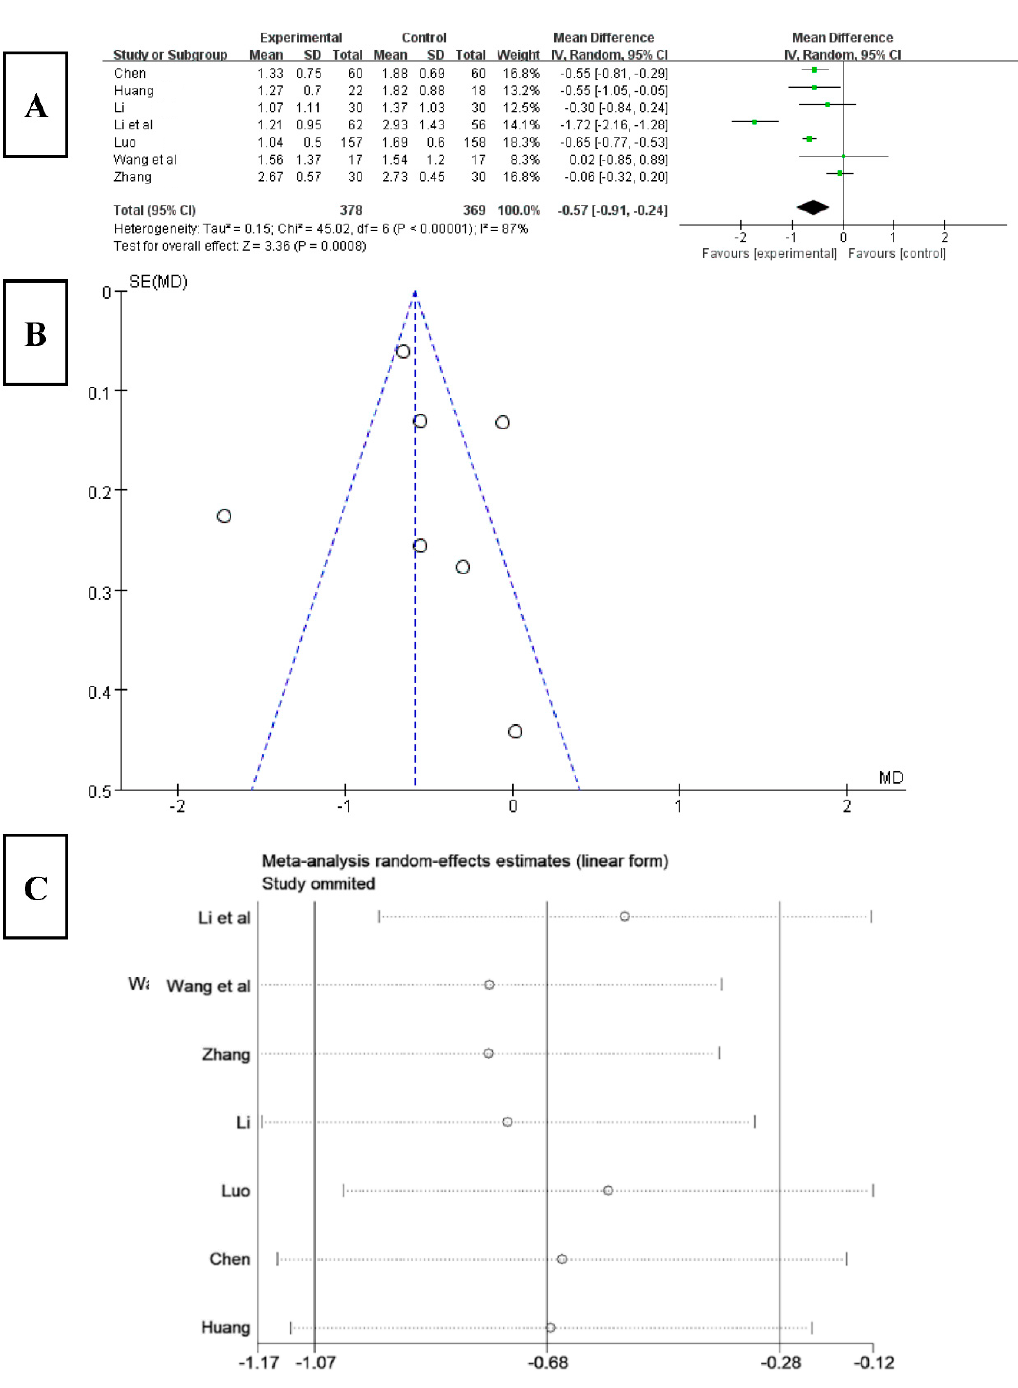
Figure 5. ( A ) Forest plot of sleep latency effect size. ( B ) Funnel chart of meta-analysis of sleep time. ( C ) Sensitivity analysis of effect size of sleep latency.